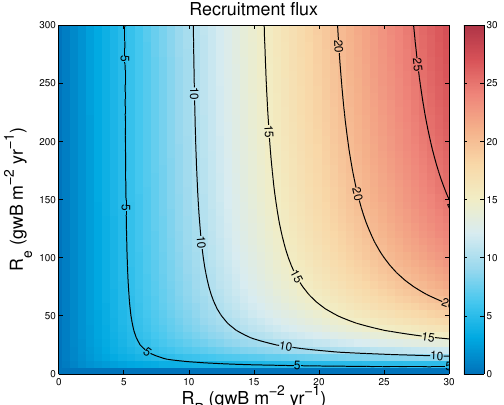
Figure 3. Recruitment flux. The recruitment flux of group k , R k (m 0 ,t) (gwBm − 2 yr − 1 , Eq. 29) as a function of the recruitment based on the boundary flux of NPP R P ,k (m 0 ,t) (gwBm − 2 yr − 1